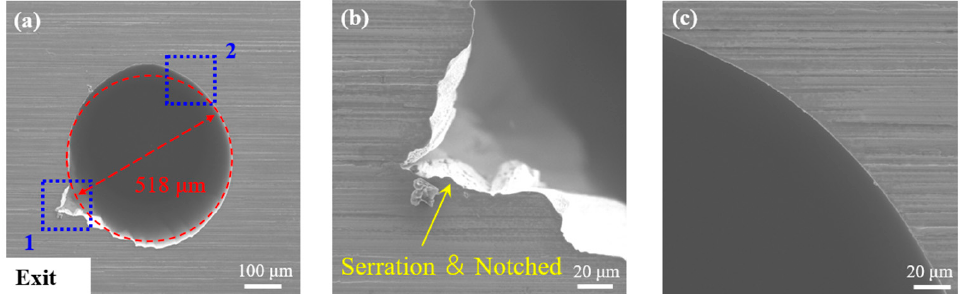
Figure 13. Enlarged view of the 3-1-3-5-2-4 exit hole morphology micro area ( a ) exit hole; ( b ) area 1; ( c ) Area 2.